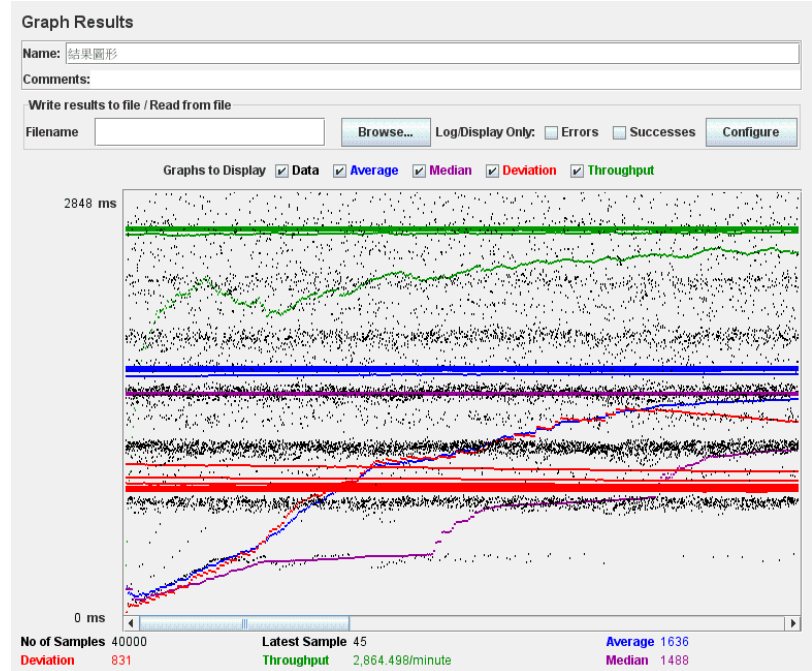
Figure 15. Single virtual machine.